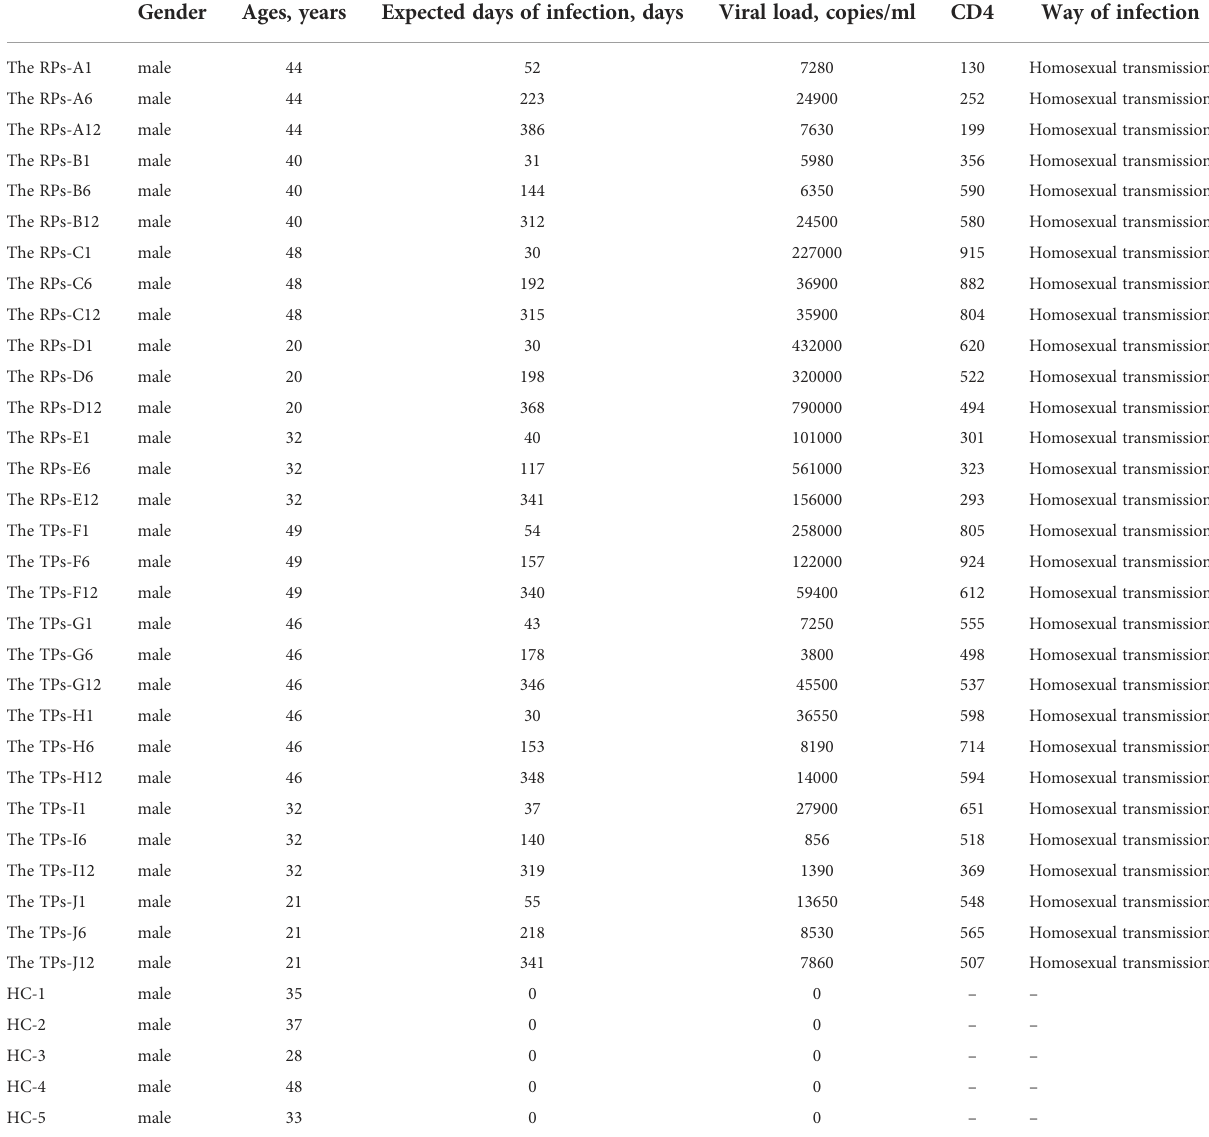
TABLE 1 The baseline Clinicopathological Characteristics of the Study Population.